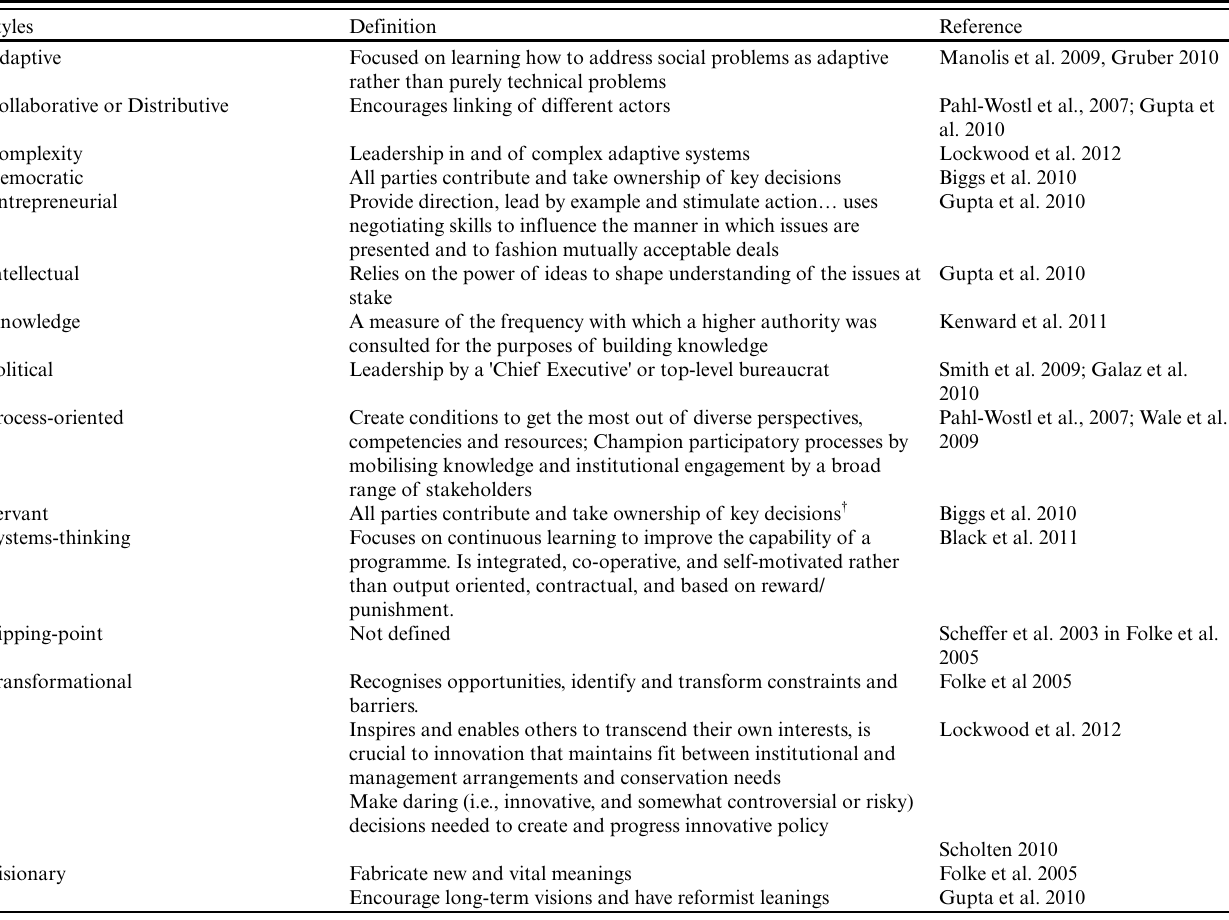
Table 2 . Leadership styles discussed and defined within the environmental sciences literature. The definitions emulate how these styles are expressed in the literature. References refer to the cases reviewed in this study that mention a particular leadership style, not to the original source or definition of the particular